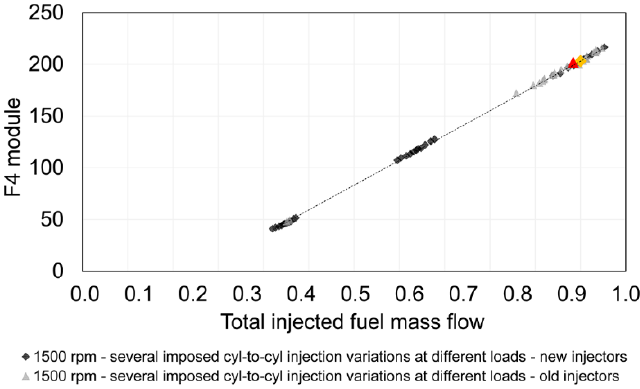
Figure 18. Representation of the F4 module as a function of the total injected fuel in case of new injectors (black diamonds) and old injectors (grey triangles) at 1500 rpm by imposing several injection variations in the cylinders at different loads. The comparison between new and old injectors at full load and 1500 rpm in case of standard injection without imposing injection variation is highlighted with the yellow diamond and the red triangle, respectively. Data is normalized with respect to the maximum injected fuel quantity.